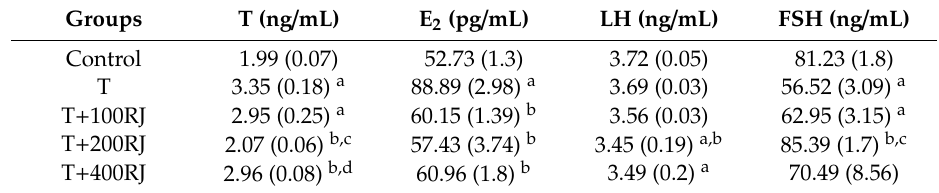
Table 3. E ff ect of royal jelly on reproductive hormones in polycystic ovarian syndrome (PCOS) rats. Groups T (ng / mL)